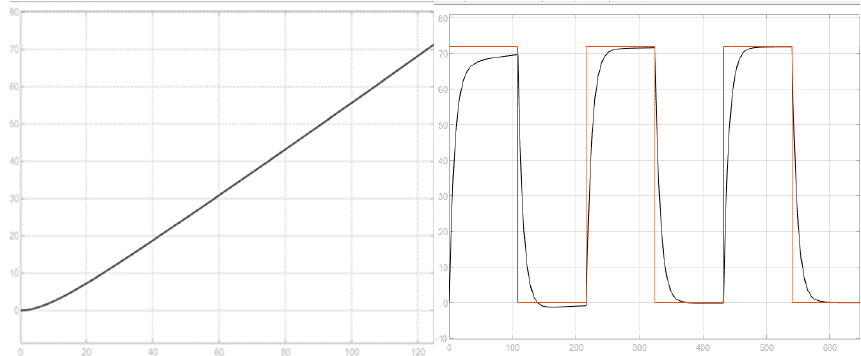
Figure 13. Response of the spinning process to a ramp and step input per cycle.